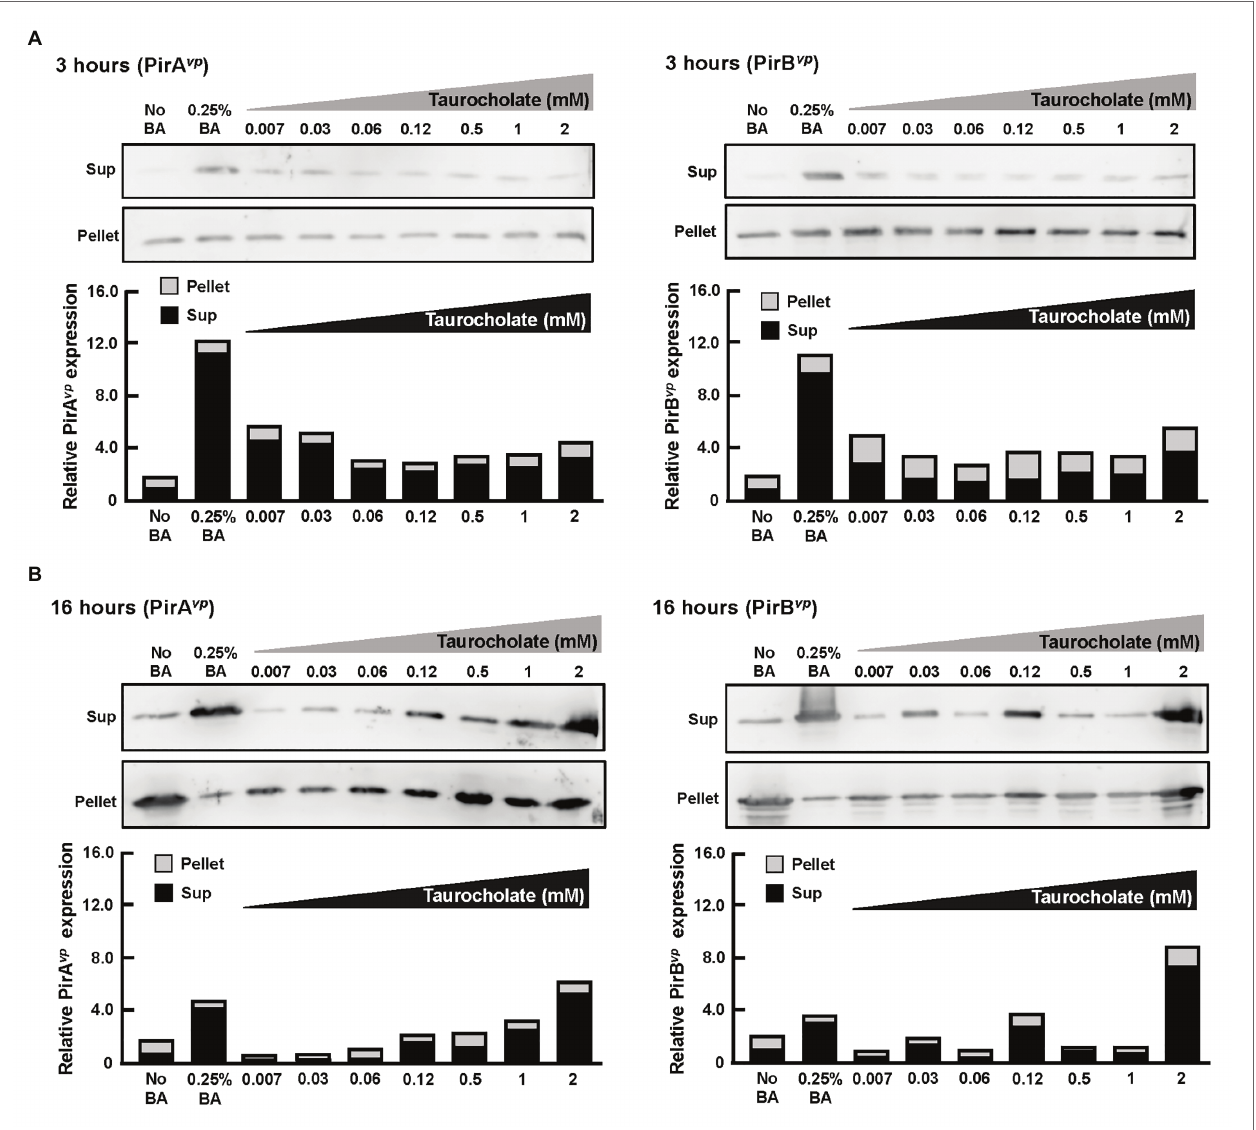
FIGURE 8 | Taurocholate stimulated PirAB vp toxin release in AHPND-causing V. parahaemolyticus . Effects of taurocholate on release of PirA vp and PirB vp toxins were assessed by Western blots. Toxin concentrations were detected in the pellet (P) and supernatant (S) of AHPND-causing V. parahaemolyticus 5HP strain cultured with taurocholate for (A) 3 or (B) 16 h. Immunoblots were probed with PirA vp and PirB vp antibodies, respectively. The intensities of each pair of immunoblots are shown graphically as relative expression in supernatant (Sup) and pellet compared to their corresponding no-bile-acid